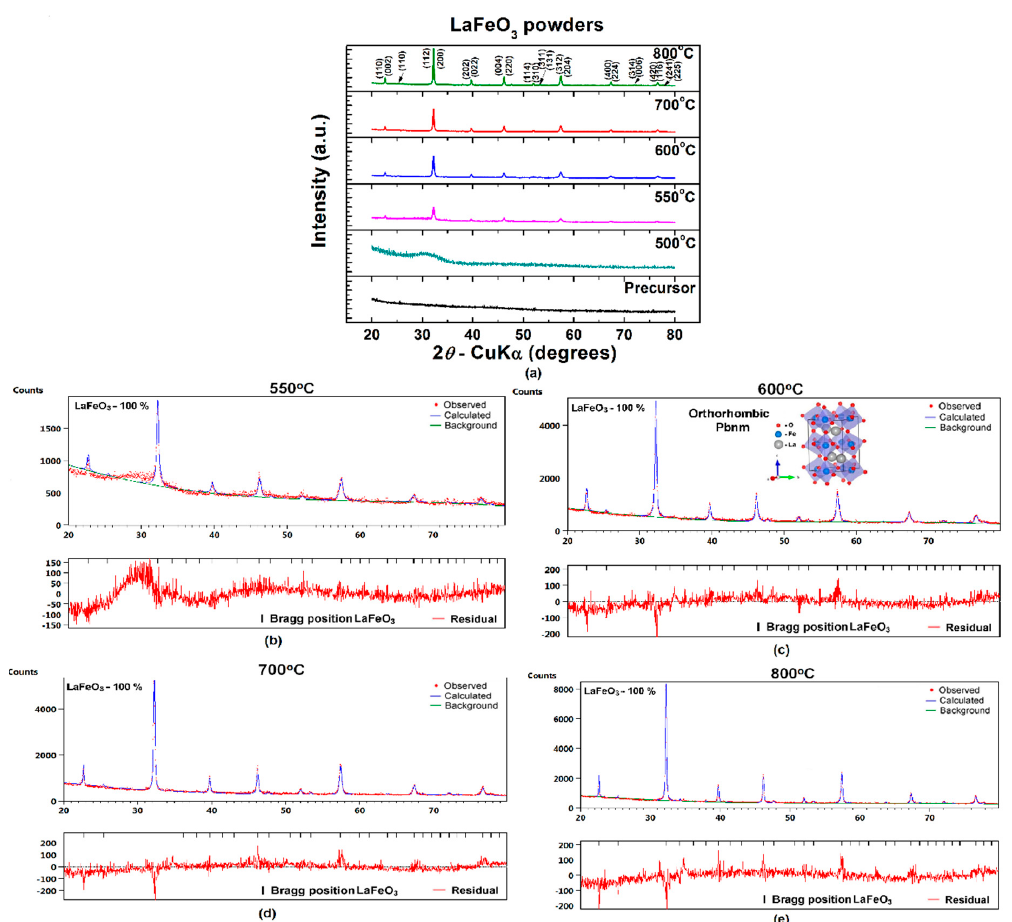
Figure 3. (a) Room-temperature XRD patterns and (b)–(e) results of Rietveld analysis of XRD data for Figure 3. ( a ) Room-temperature XRD patterns and ( b – e ) results of Rietveld analysis of XRD data for LaFeO 3 powders calcined at various temperatures: ( b ) 550, ( c ) 600, ( d ) 700, and ( e ) 800 ◦